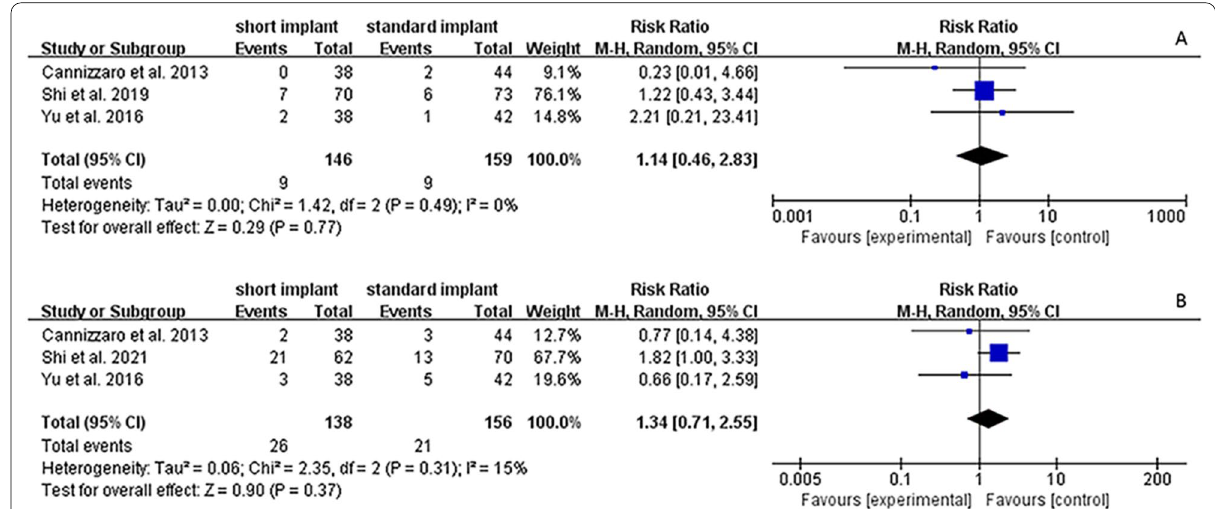
Fig. 7 Forest plots for intra-surgical complication, and postoperative complication. A Forest plot for risk ratio (RR) of intra-surgical complication between short implants with OSFE and standard implants with SFE. B Forest plot for risk ratio (RR) of post-surgical complication between short implants with OSFE and standard implants with SFE. CI confidence